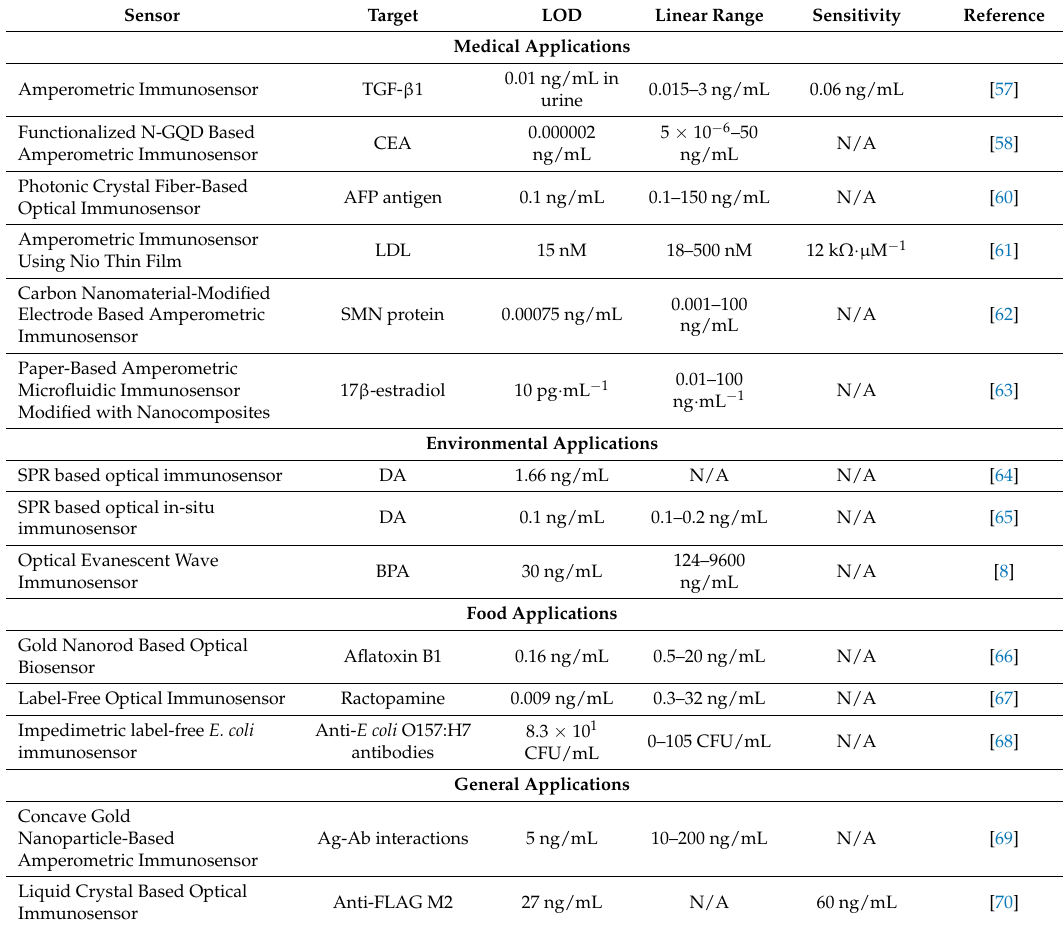
Table 4. Analytical performances of recent publications on